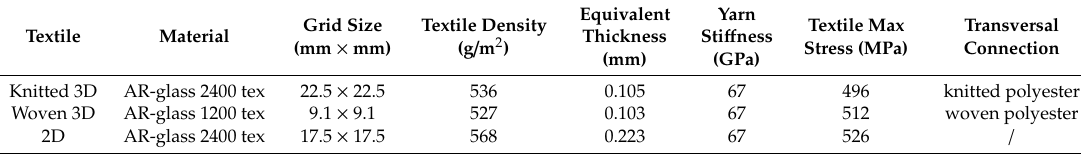
Table 2. Properties of the cementitious matrix, based on [27].